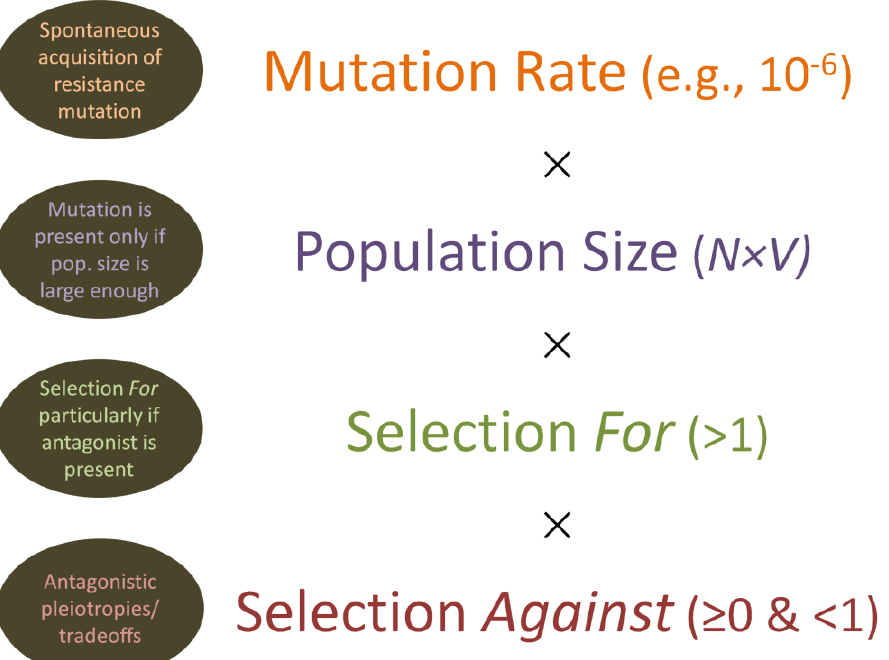
Figure 7. Mutation to resistance, along with selection for and against those mutations. Mutations are assumed to occur spontaneously at some rate per bacterial generation, can be somewhat lower or higher in frequency than the indicated 10 − 6 (e.g., 10 − 7 , 10 − 8 , or 10 − 5 ), and will tend to occur independently of any selecting force. For “Population size”, N × V refers to bacterial concentration ( N ) multiplied by the volume ( V ) of the occupied environment. Resistance mutations, by definition, are selected for when the selective agent is present. These same mutations, however, can also be detrimental to the functioning of the otherwise resisting organism, resulting also in some degree of selection against (i.e., as due to antagonistic pleiotropic effects, also known as tradeoffs). If selection for is stronger than selection against , then the resistance allele should increase in frequency within a population as long as the selecting agent is present. Otherwise, the resistance allele typically, though not always, should decrease in frequency as a consequence of selection against. Note that selection against, in Darwinian fitness terms, is equal to zero if the resistance allele is lethal to carrying individuals. Note otherwise that the timeline of both mutation and selection is not explicitly indicated in the